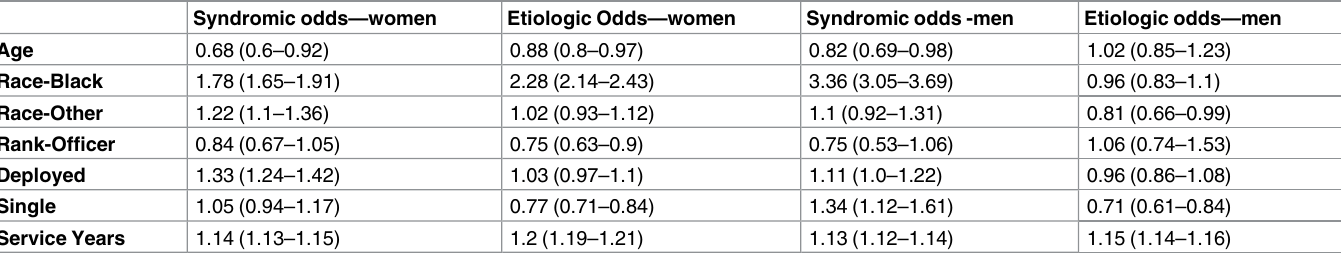
Table 5. Multivariate analysis of factors associated with STI diagnosis during military